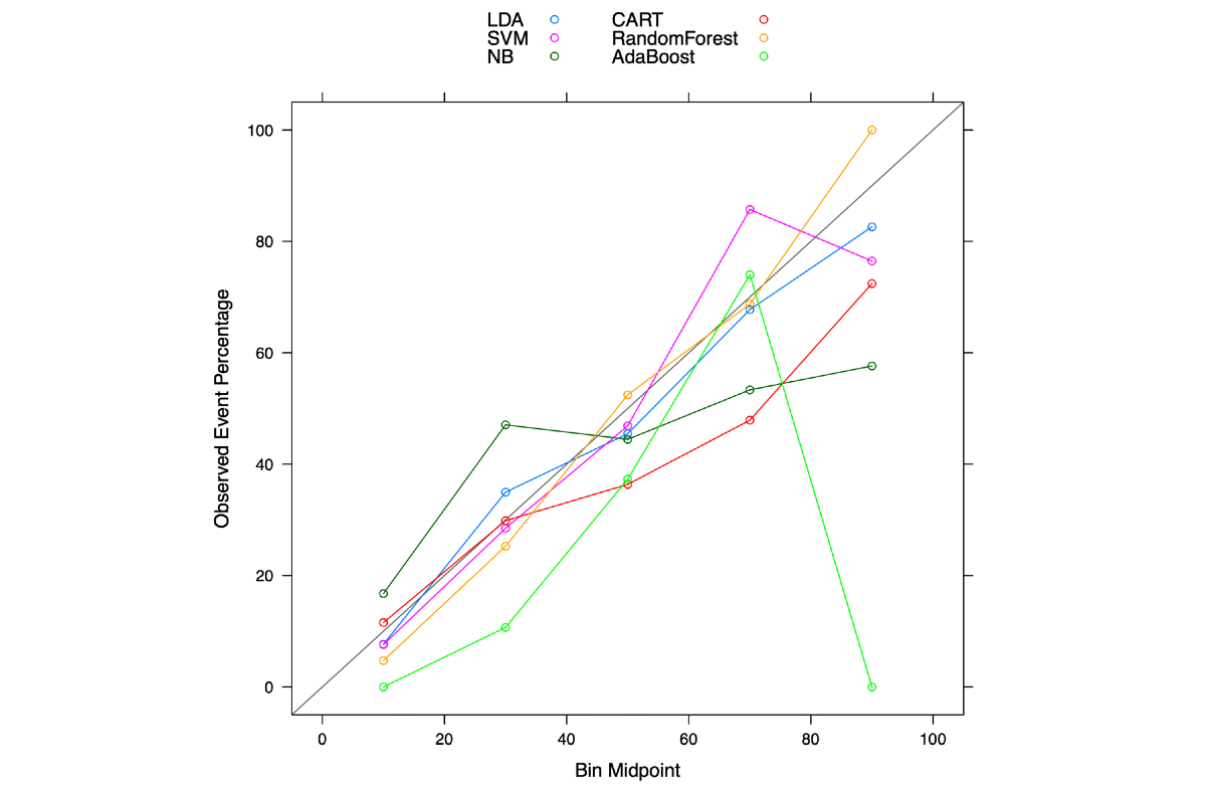
Figure 6. Calibration plots of classification and regression tree (CART), supervised machine learning (SVM), linear discriminant analysis (LDA), random forest, naive Bayes (NB), and adaptive boosting